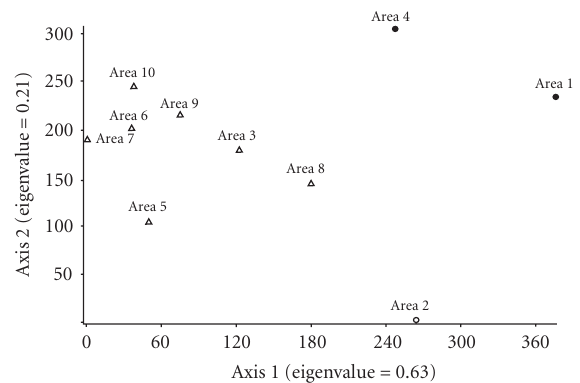
Figure 4: Ordination diagram in first two axes of detrended cor- respondence analysis (DCA) of ten sites of seasonal semideciduous forest in southeastern Brazil. Symbols correspond to floristic groups 1 ( (cid:2) ), 2 ( • ), and 3